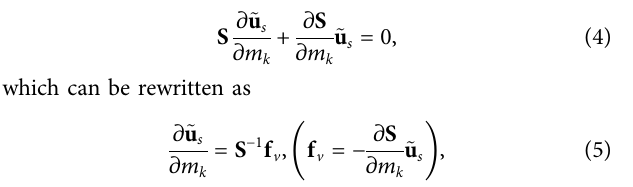
Frontiers in Earth Science |